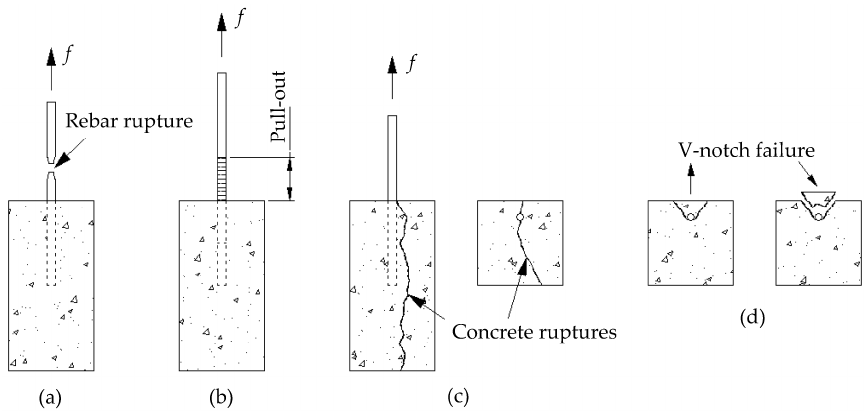
Figure 5. Expected failure modes. ( a ) Rebar rupture side view; ( b ) Pullout side view; ( c ) Splitting